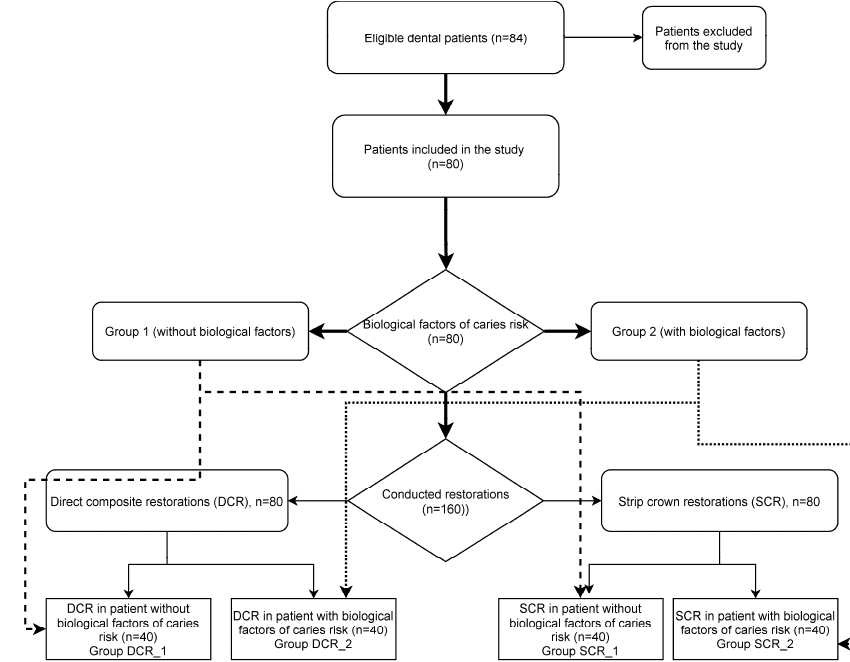
Figure 1. Flow diagram for study participants and study interventions.